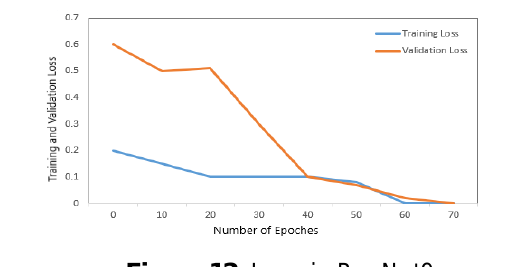
Figure 12. Loss in